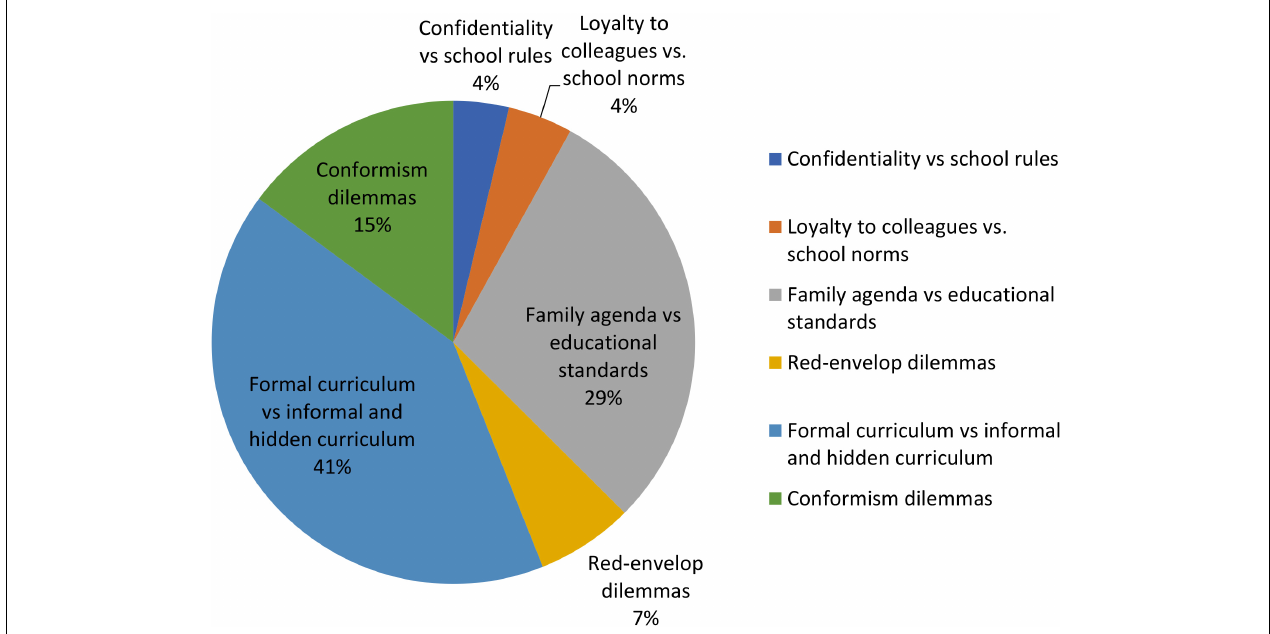
FIGURE 1 | Distribution of ethical